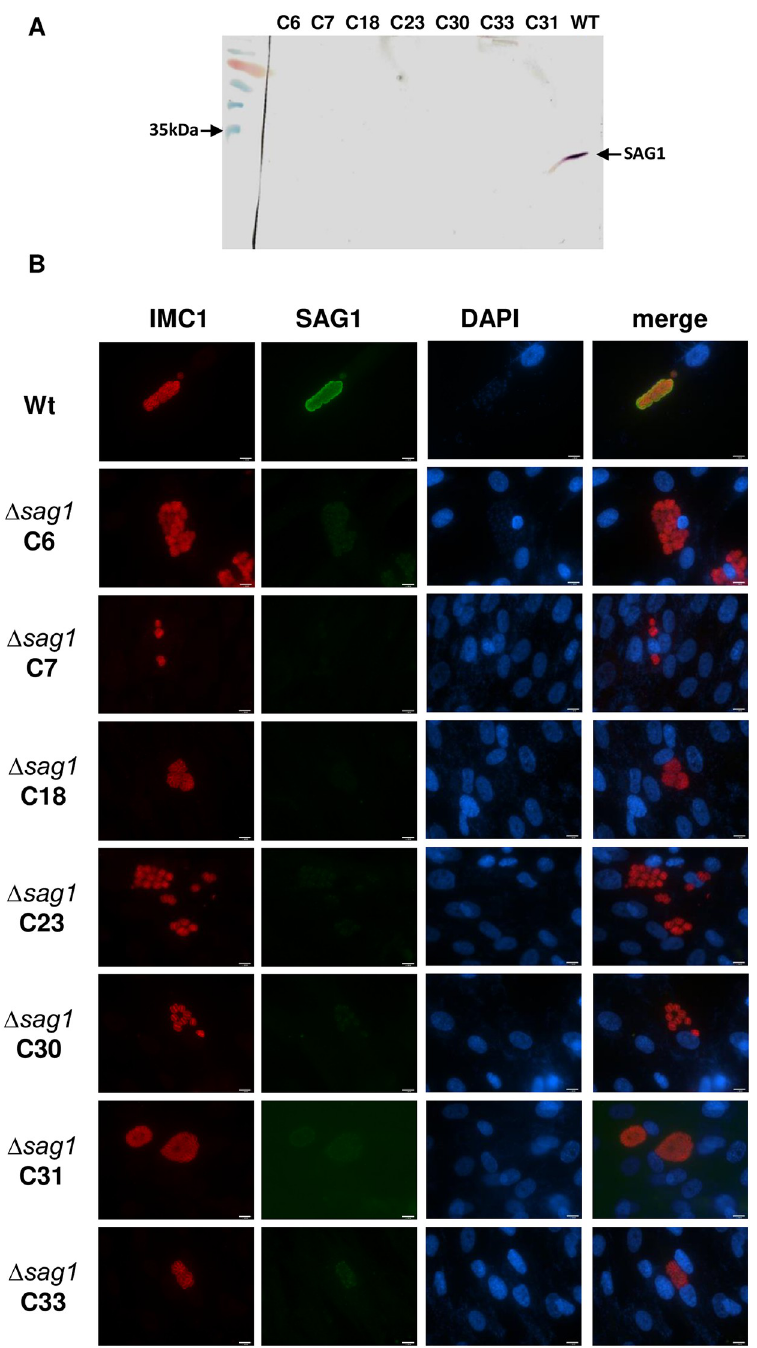
Fig 2. Loss of sag1 expression in T . gondii RH SAG1 knockouts by (A) Western blot analysis and (B) immunofluorescence.